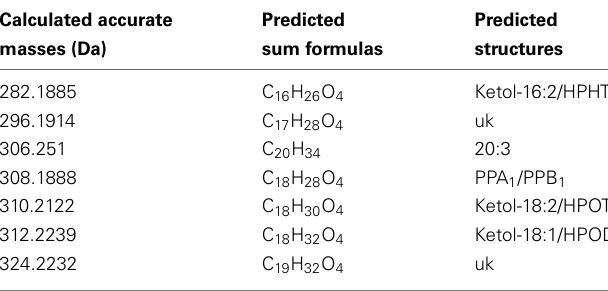
Table 3 | Predicted sum formulas and their predicted structures of some unknown acyl side chains deduced from accurate mass measurements